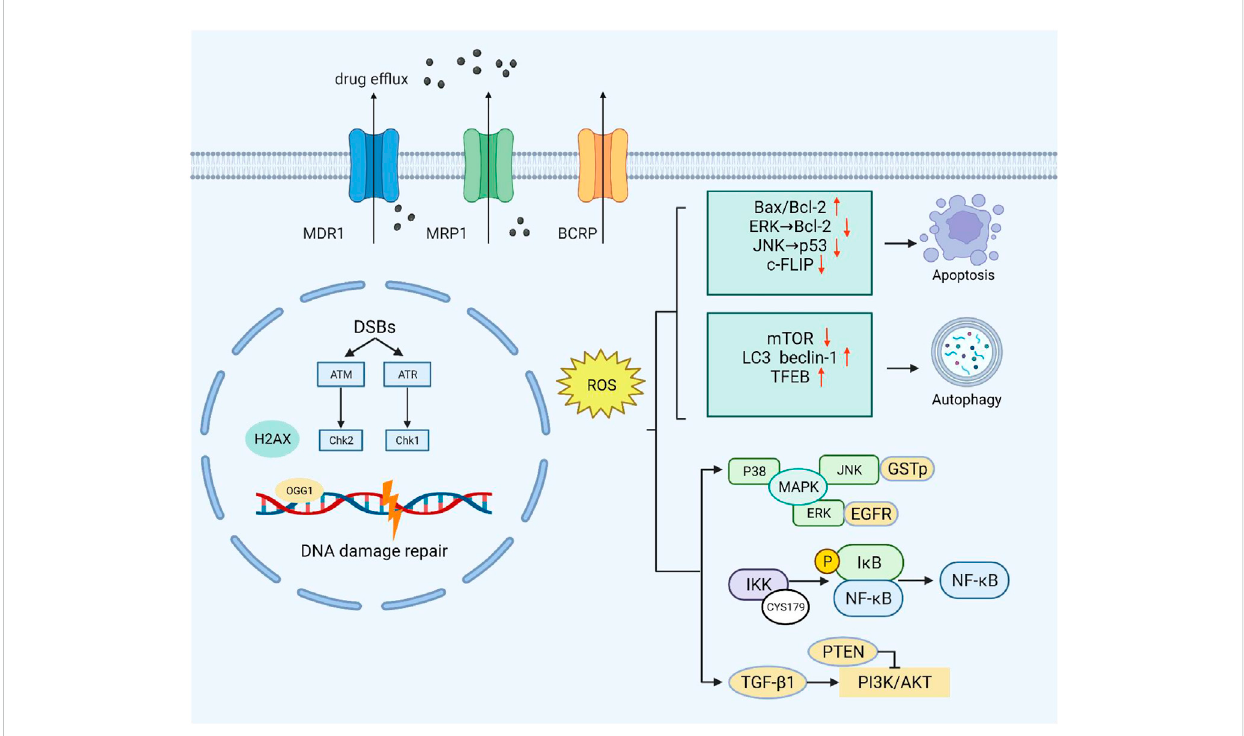
FIGURE 1 Moderate ROS levels can limit the anticancer activity of drugs by increasing drug ef fl ux. Excessive ROS can cause endogenous DNA damage and inhibit the DNA damage repair response. At high ROS levels, death receptor-mediated and mitochondrial pathways are triggered to induce apoptosis. ROS can also inhibit the negative regulators of autophagy (mTOR) and increase the formation of autophagosomes by upregulating autophagy-related genes. At low levels, ROS act as second messengers by mediating multiple signaling pathways (PI3K/AKT, MAPK, and NF- κ B) that contribute to cancer cell survival and